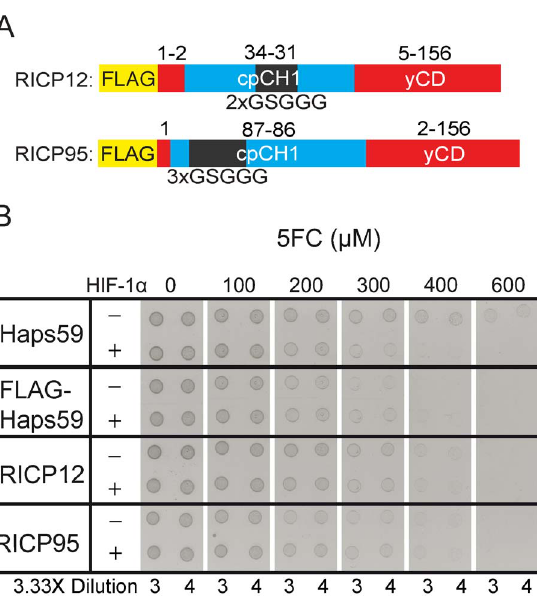
Figure 4. Characterization of RICP12 and RICP95 in E. coli . (A) Diagrams of RICP12 and RICP95 sequences identified from the random circular permutation and random insertion library. Numbers above indicate the amino acid residues of the corresponding wild-type proteins. Letters below indicate the 1-letter abbreviation of the amino acid linker sequence used in the circular permutation of the CH1 domain. (B) Dot toxicity assay of RICP12 and